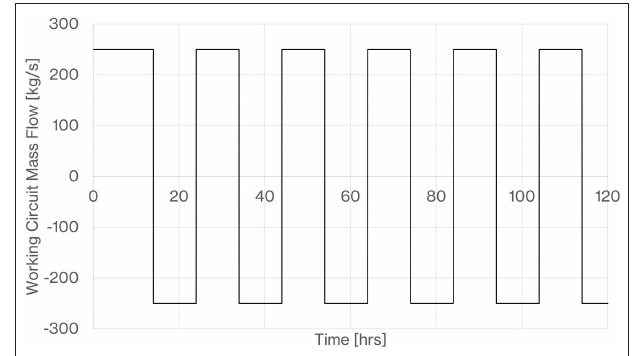
FIGURE 14 | Hot store temperature profiles ( z = 0 is top, z = 10m is bottom). (a) After initial charge, (b) after initial discharge, (c) after 100 charge cycles, after 100 discharge